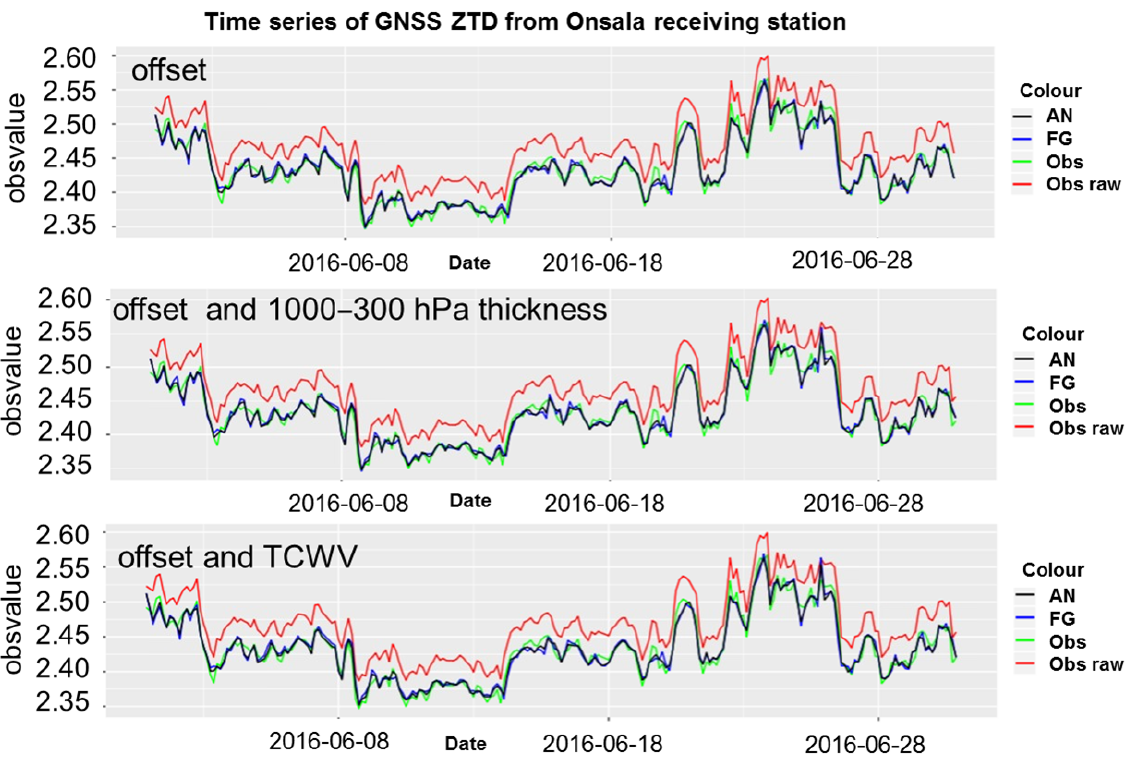
Figure 7. One-month time series of GNSS ZTD (unit: m) from the Onsala receiver station. Analysed (black), background (blue), observation after bias correction (green) and observation before bias correction (red).